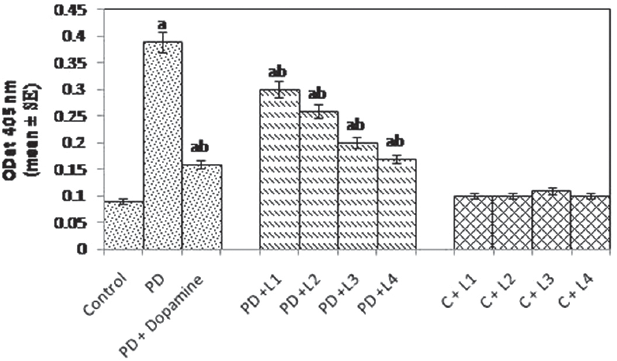
FIGURE 6 - Effect of luteolin on caspase-9 activity in the brains of flies. [L1= 25 µM; L2= 50 µM; L3 = 75 µM; L4= 100 µM; PD = PD flies; Dopamine=10-3 M]. The flies were allowed to feed on the diet supplemented with luteolin for 24 days and then assayed for caspase-9 activity. The values are the mean of 5 assays. [a - significant at p<0.05 compared to control; b - significant at p<0.05 compared to PD flies].